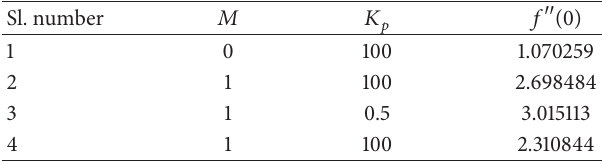
Table 1: Skin friction